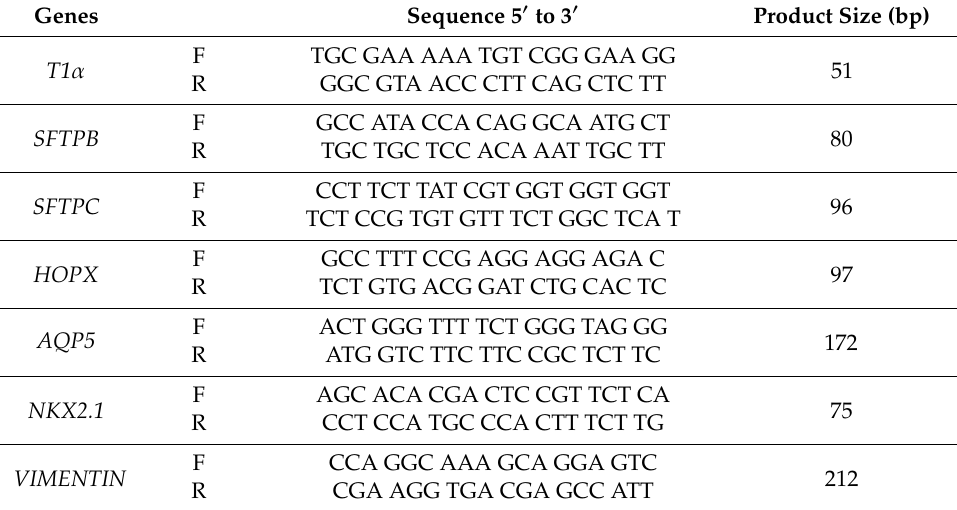
Table 1. Primer sequences used for